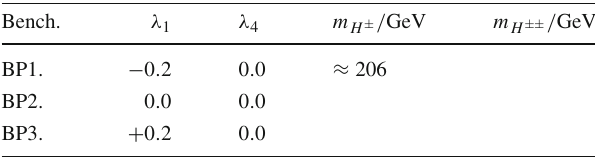
Table 1 Benchmark points for Fig. 4